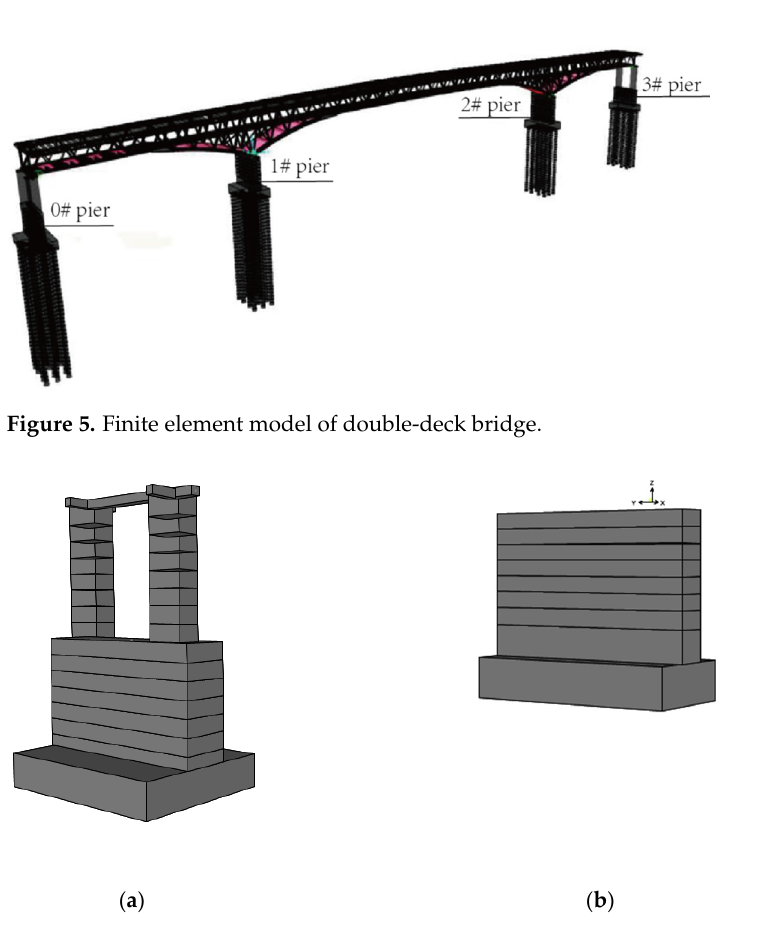
Figure 6. Finite element model of piers. ( a ) 0# pier and 3# pier. ( b ) 1# pier and 2# pier.